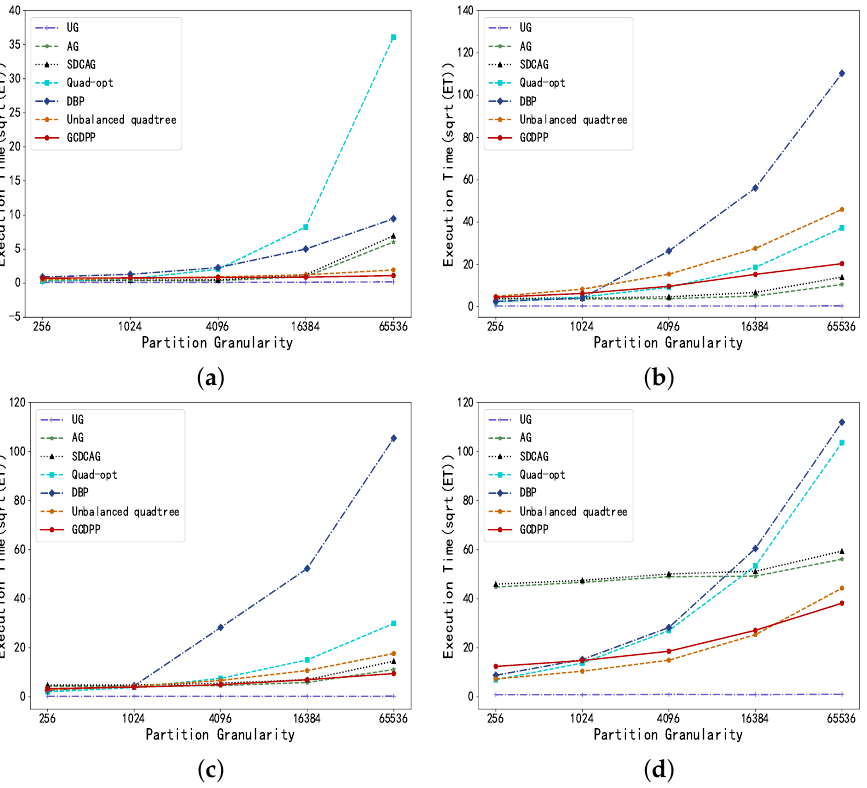
Figure 17. Partition granularity vs. execution time. ( a ) Storage dataset, (cid:101) = 1; ( b ) Landmark dataset, (cid:101) = 1; ( c ) Checkin dataset, (cid:101) = 1; ( d ) Yellow_trip dataset, (cid:101) =